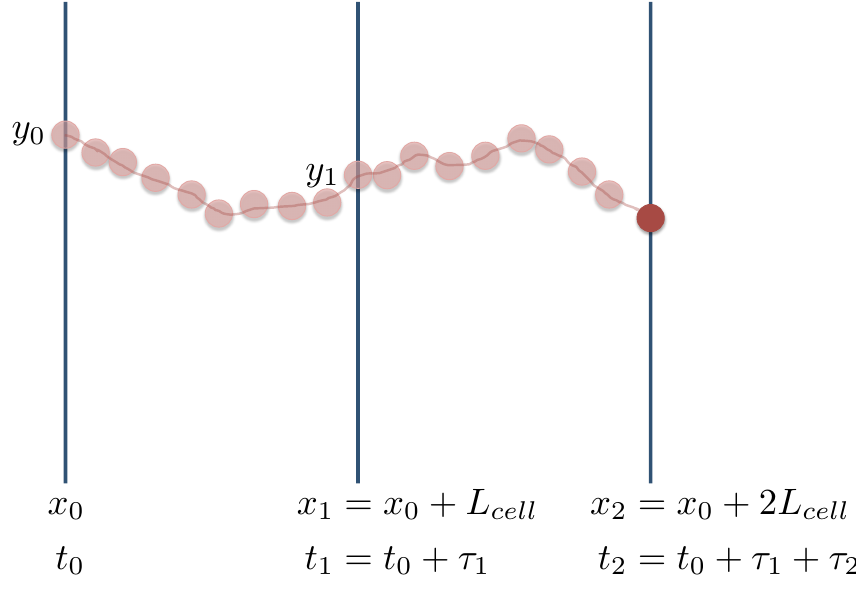
Figure 4. Diagram illustrating the parameterization step for the upscaled model. Each particle moves by random walk over a distance of two cell lengths and the particle’s initial y position ( y 0 ), y position at the inlet of the second cell ( y 1 ), and travel times through the first and second cells ( τ 1 and τ 2 , respectively) are recorded. The red circles represent an example of a single particle